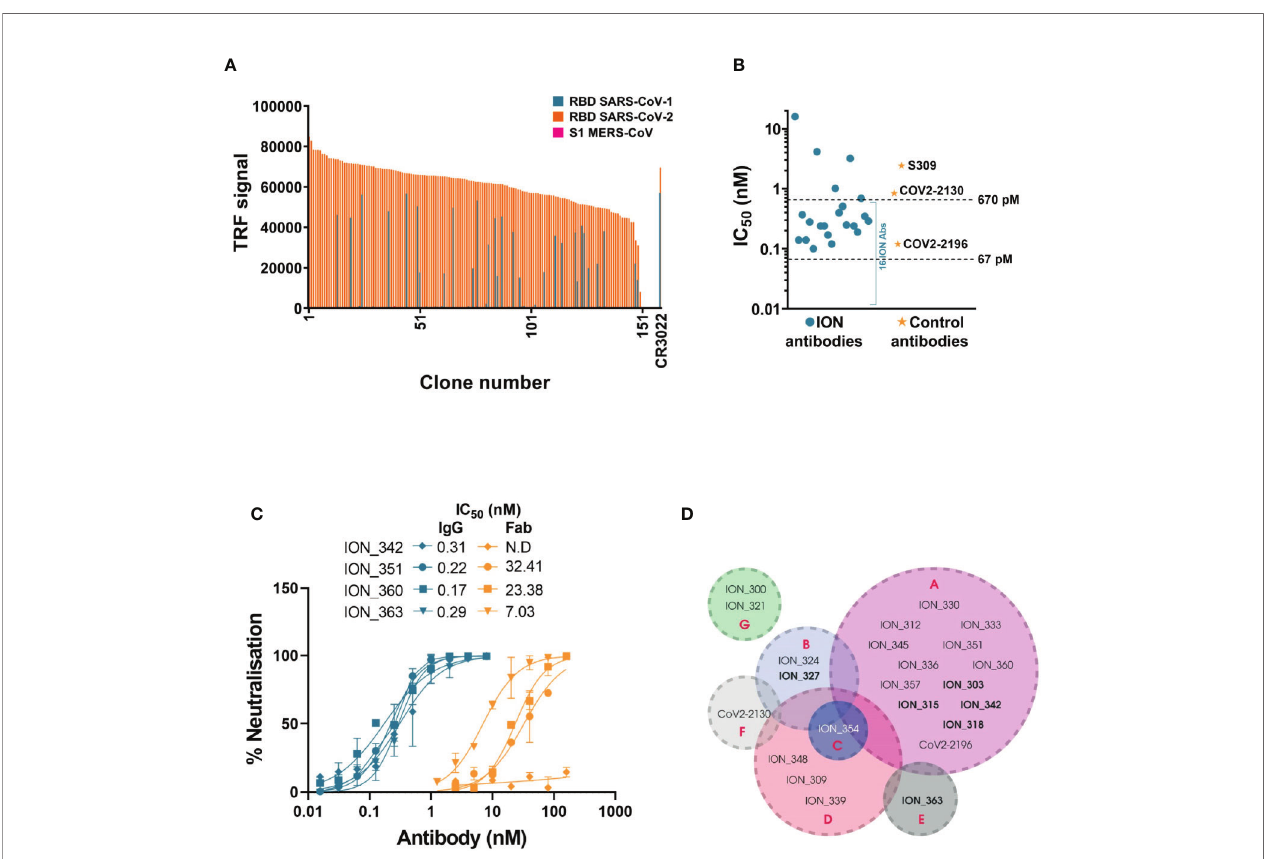
FIGURE 3 | Detailed characterization of SARS-CoV-2 antibodies. (A) Evaluating the cross reactivity of 155 SARS-CoV-2 antibodies to SARS-CoV-1 RBD and MERS CoV S1. CR3022, a previously published binding SARS-CoV-1 and SARS-CoV-2 cross reactive antibody was used as control. (B) Authentic SARS-CoV-2 neutralizing activity of a panel of 21 SARS-CoV-2 antibodies and control antibodies. (C) Comparing authentic SARS-CoV-2 neutralizing activity of 4 antibodies, in Fab and IgG format. Error bars indicate standard deviation. (D) Epitope binning of SARS-CoV-2 antibody panel using Octet BioLayer interferometry. The bins are labeled A to G. Antibodies in bold text denote capture molecules that exhibited unidirectionality.